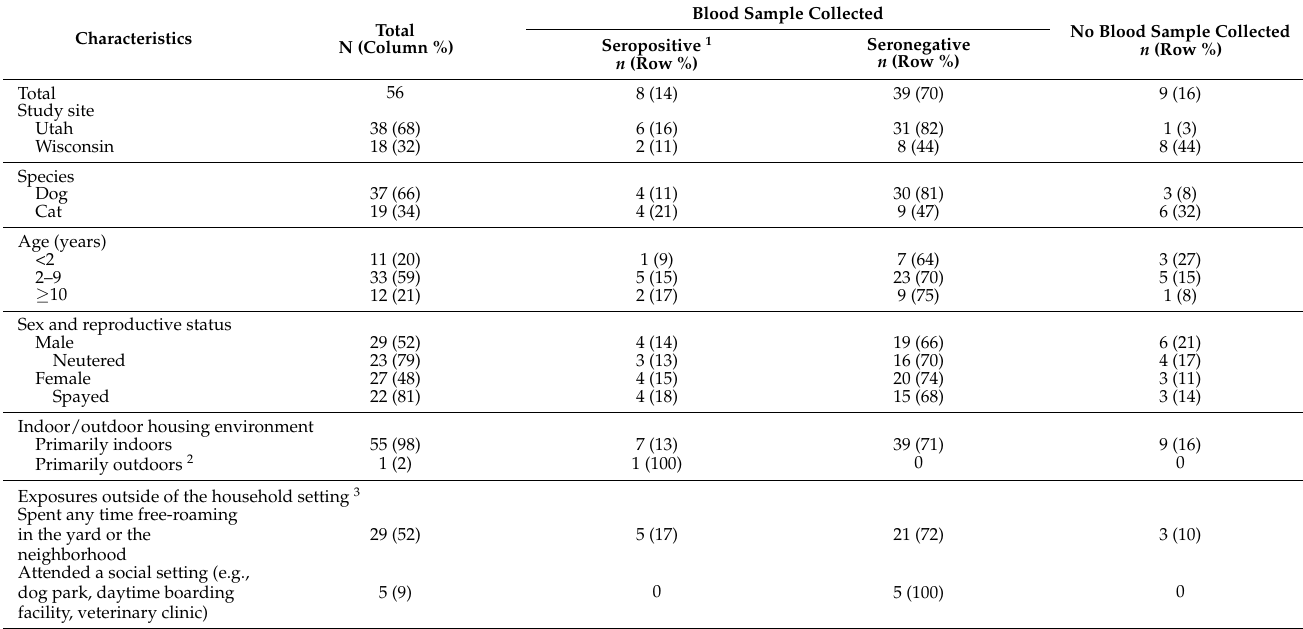
Table 1. Characteristics of household pets enrolled in the One Health COVID-19 Household Transmission